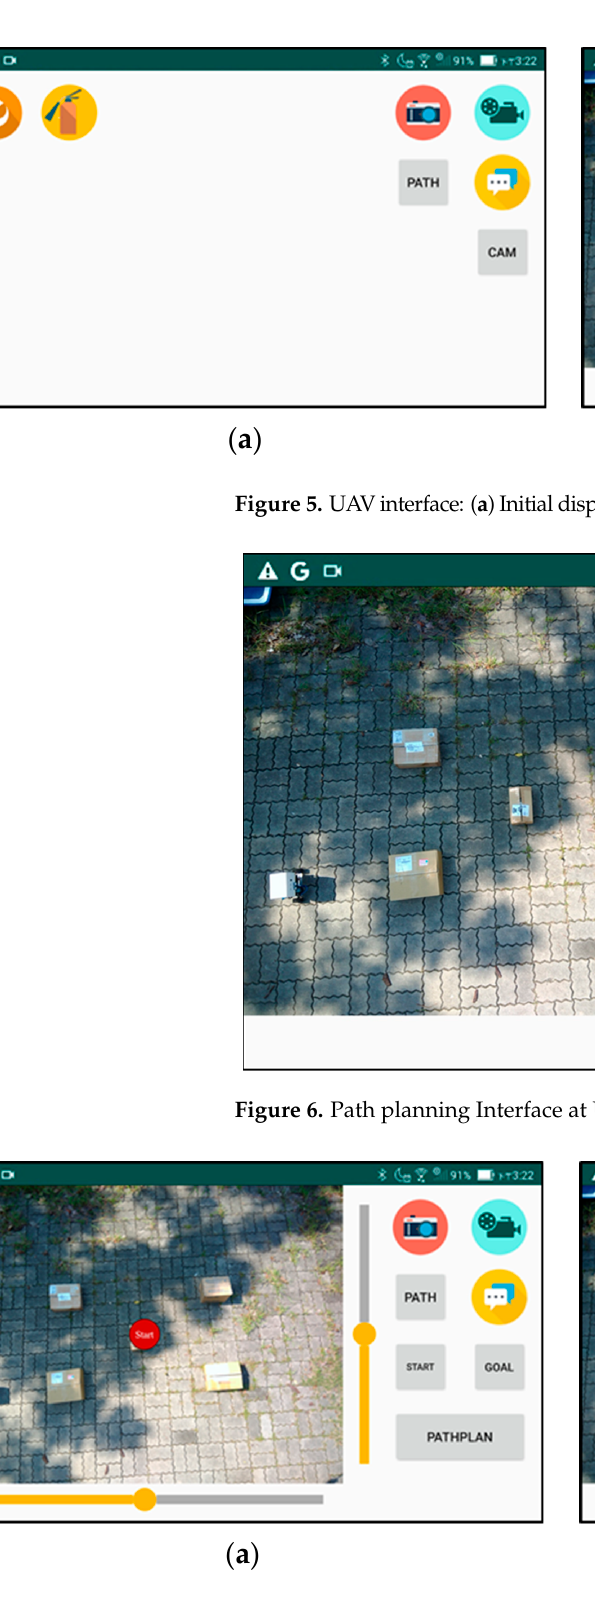
Figure 7. Path planning from UAV interface: ( a ) Setting starting point; ( b ) Setting goal point.